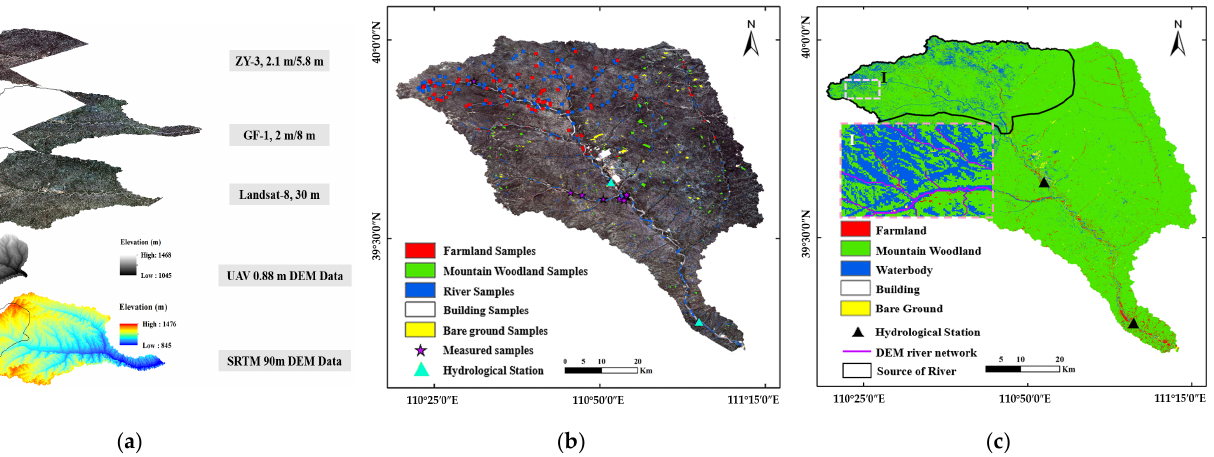
Figure 3. Data sources and samples in the study area. ( a ) The multisource remote sensing data of the Huangfuchuan River Basin used in this research. ( b ) The distribution of machine learning samples and validation samples in the Huangfuchuan River Basin. ( c ) Land use types in the Huangfuchuan River Basin. Region I shows the poor results of waterbody extraction in the source area.